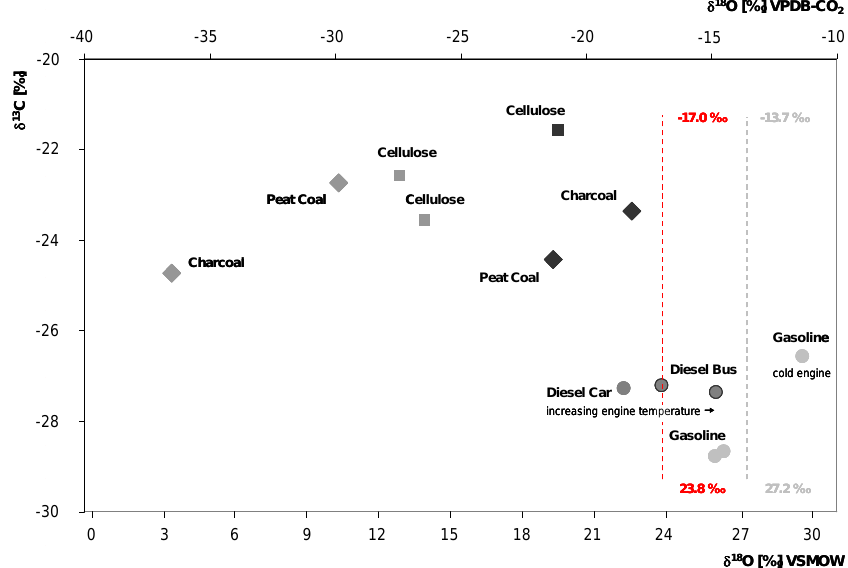
Fig. 7. Isotopic signature of the used oxygen sources (dotted lines: 27.2‰ dedicated to the pure oxygen cylinder, and 23.8‰ to the ambient air source) and of the combustion-derived CO 2 . The samples which originate from combustion with ambient air are indicated by circles (car exhaust), and by the black symbols (solid material, laboratory study). In contrast the light grey symbols denote the combustion results of the solid material with the pure oxygen